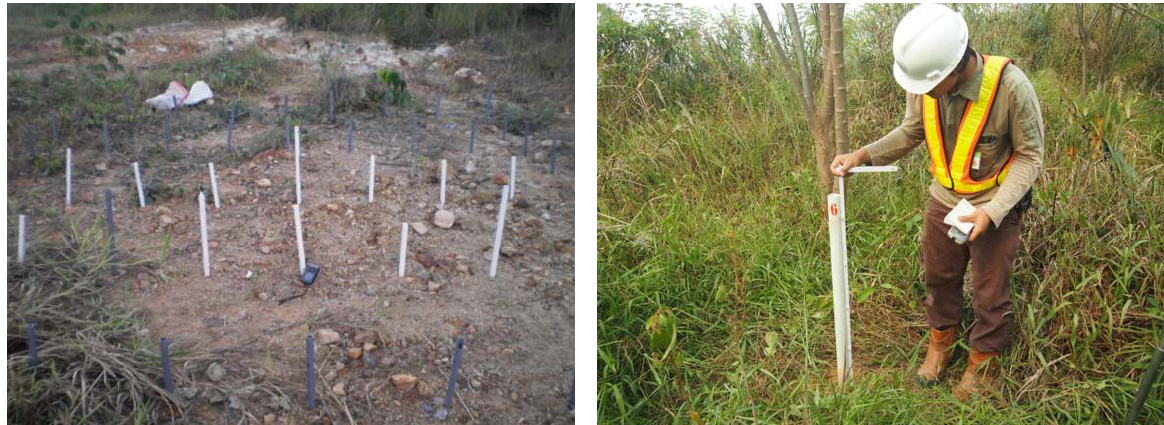
Figure 5. Measurement of the rate of erosion using erosion sticks. Photo by I. Iskandar.